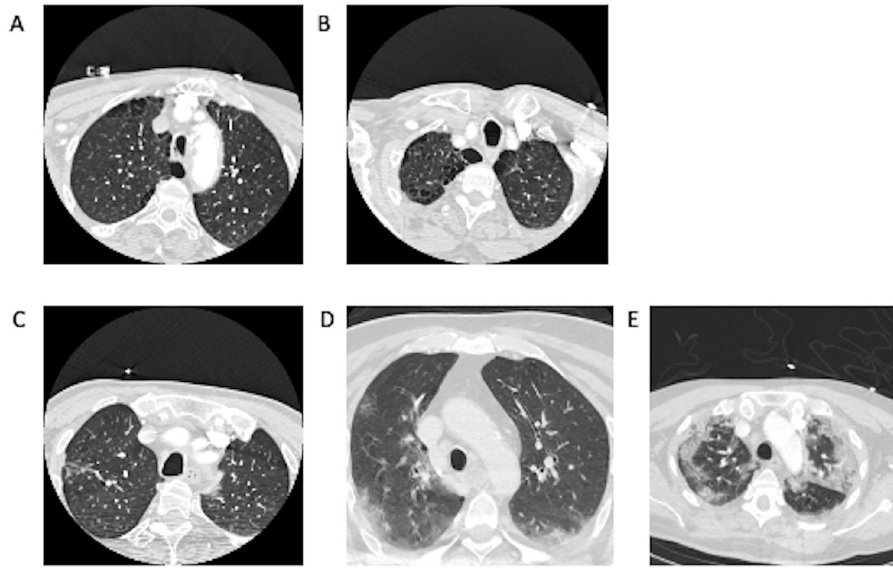
Fig 3. Examples for each COVID-19 Reporting and Data System (CO-RADS) score as evaluated in neck computed tomography angiography source image.